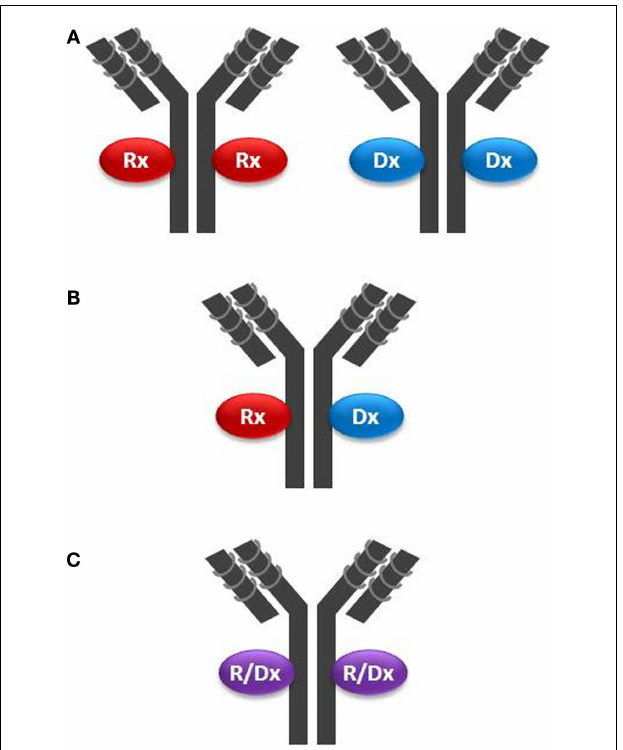
FIGURE 2 | Configurations of theranostic agents: (A) two separate batches of the same targeting moiety (in this example a mAb) are conjugated with either a therapeutic agent (Rx) such as a cytotoxin, or a diagnostic agent (Dx) such as a radionuclide; (B) the same batch of a mAb is conjugated with both Rx and Dx agents on the same targeting molecule; and (C) the same batch of a mAb is conjugated with an agent having both Rx and Dx properties (R/Dx), such as Lutetium-177, on the same targeting molecule .